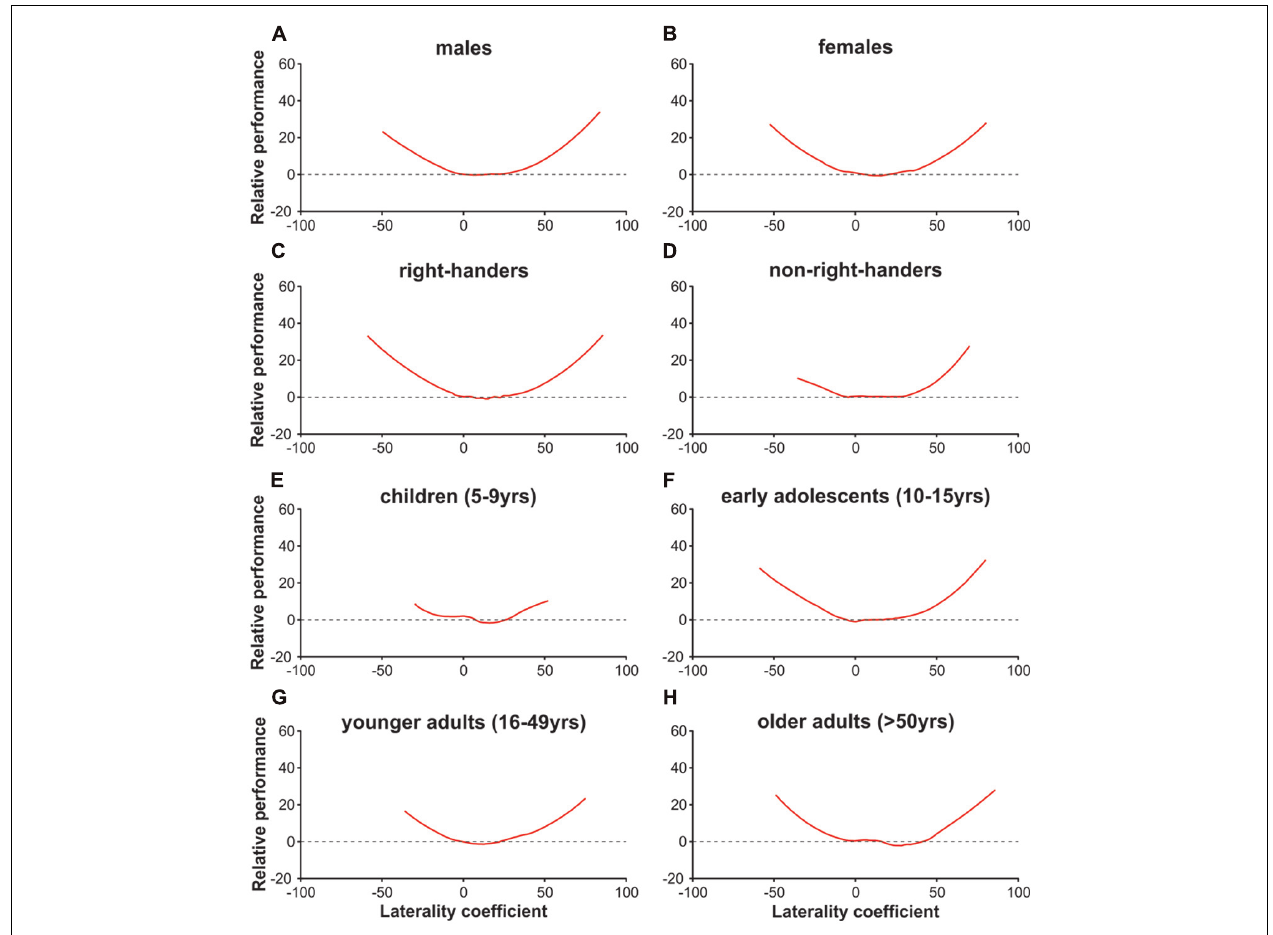
FIGURE 4 |The relationship between (relative) performance and degree of lateralization with the alternative approach in males (A), females (B), right-handers (C), non-right-handers (D), children aged 5–9 (E), early adolescents aged 10–15 (F), younger adults aged 16–49 (G), and older adults aged 50 +